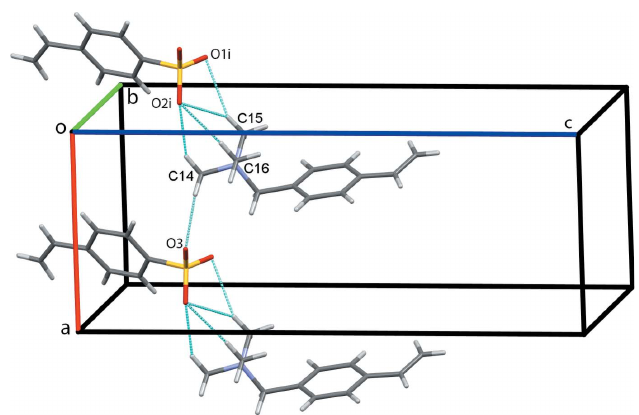
Figure 2 Chains of cations and anions of (I) along the a axis. Hydrogen bonds are shown as cyan dotted lines [symmetry code: (i) x (cid:3) 1, y , z ].